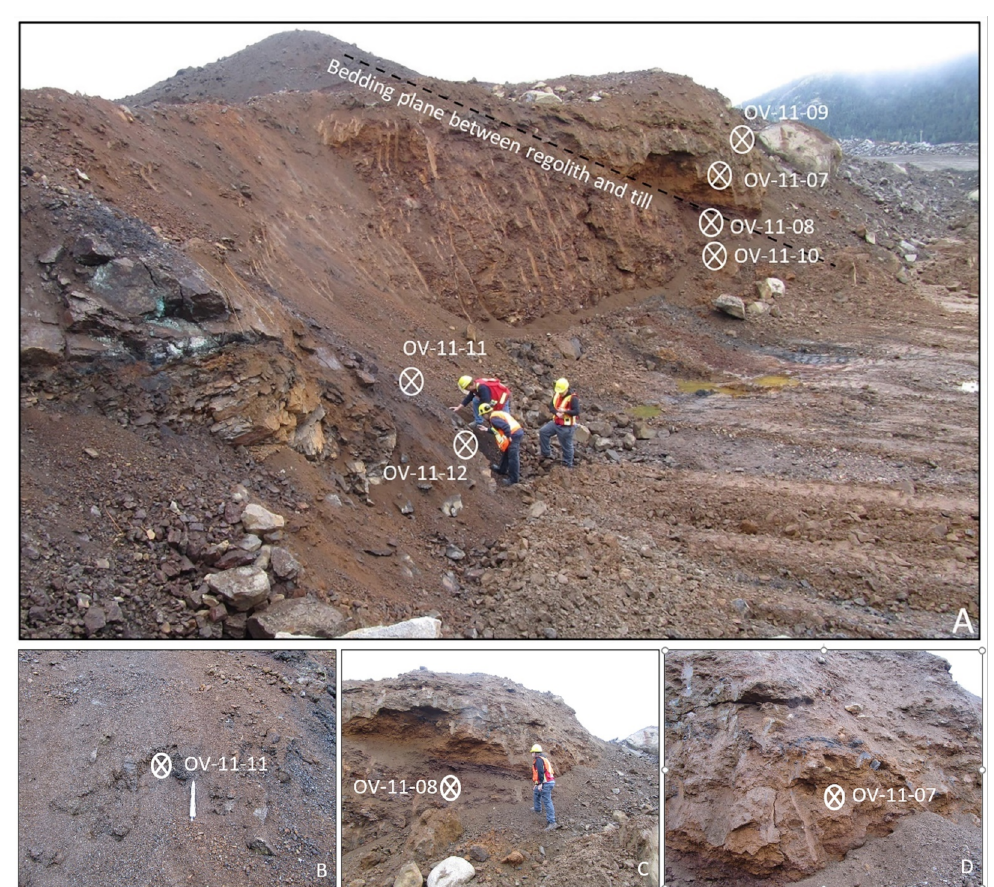
Figure 11. ( A ) OV-11 sample locations in the Mini-Ovoid Pit transect; the planar boundary between till and underlying regolith is plotted on the far face; ( B ) Regolith at site OV-11-11, pen for scale; ( C ) Site OV-11-08 and the contact between regolith and till; ( D ) Till at site OV-11-07, cobbles in till are up to 15 cm